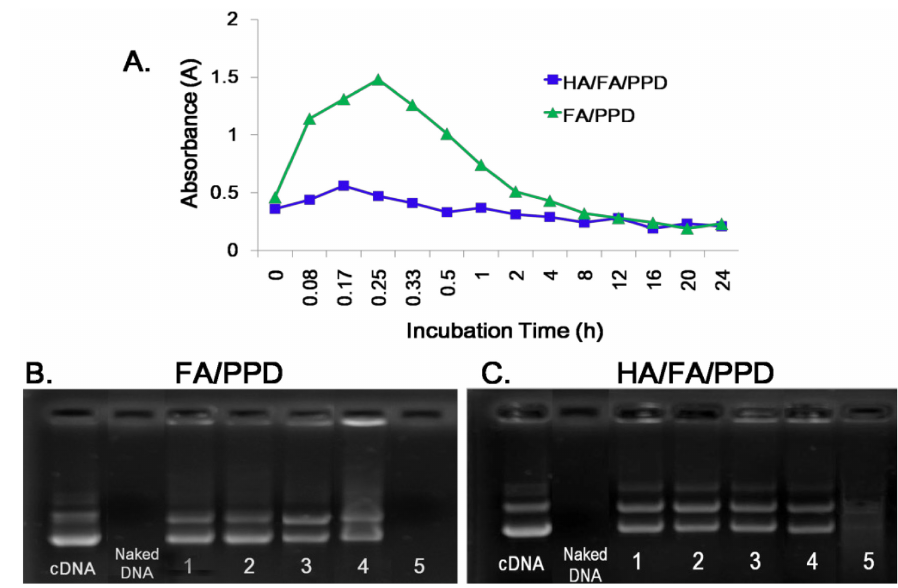
Figure 4. Stability of HA/FA/PPD in different media. ( A ) The turbidity change of HA/FA/PPD in presence of plasma with different incubation time; ( B ) Stability of FA/PPD against DNase I. Lanes 1–5: FA/PPD incubated with DNase I for 0.5, 1, 2, 3 and 4 h, respectively; and ( C ) Stability of of HA/FA/PPD against DNase I. Lanes 1–5: HA/FA/PPD incubated with DNase I for 0.5, 1, 2, 3 and 4 h,